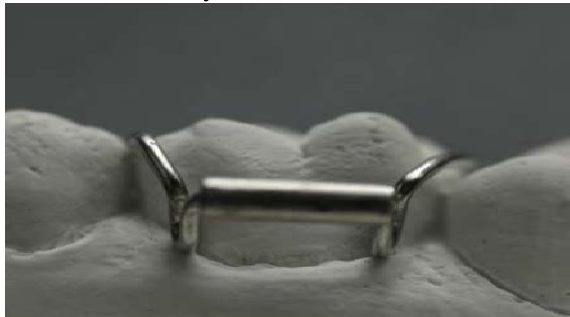
Fig. Adam’s clasp with soldered buccal